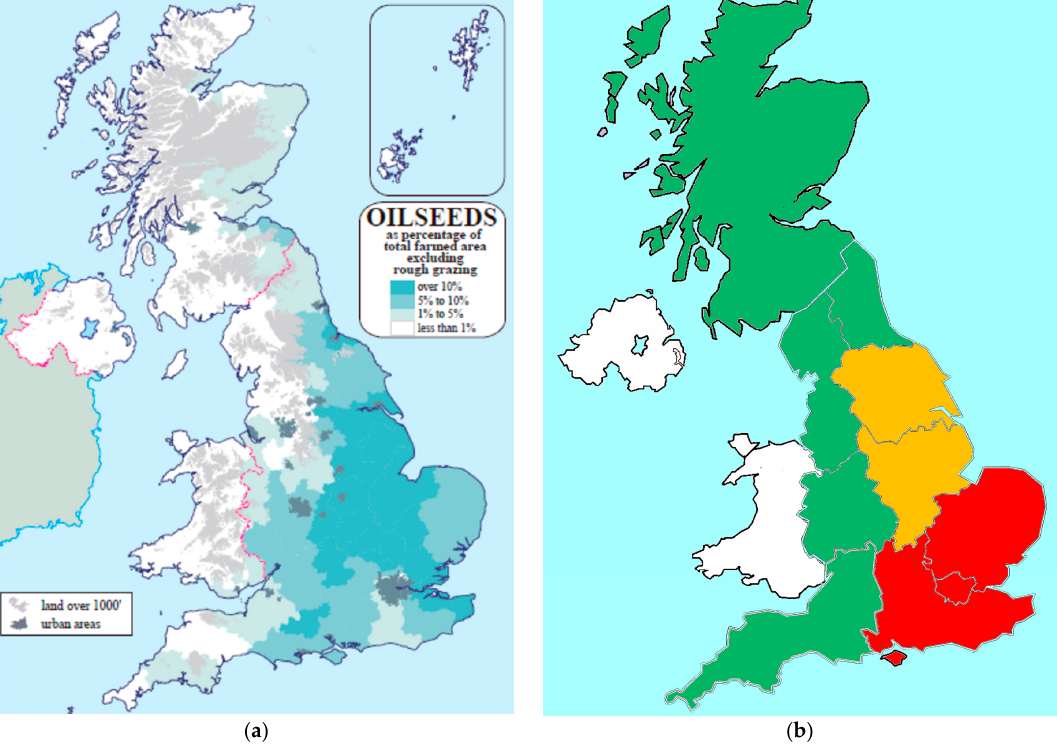
Figure 4. Incidence and severity of adult cabbage stem flea beetle in winter oilseed rape in the UK in 2015 [44] ( a ) Cropping Intensity ( b ) Insect severity. Red = Highest Loss and Risk.